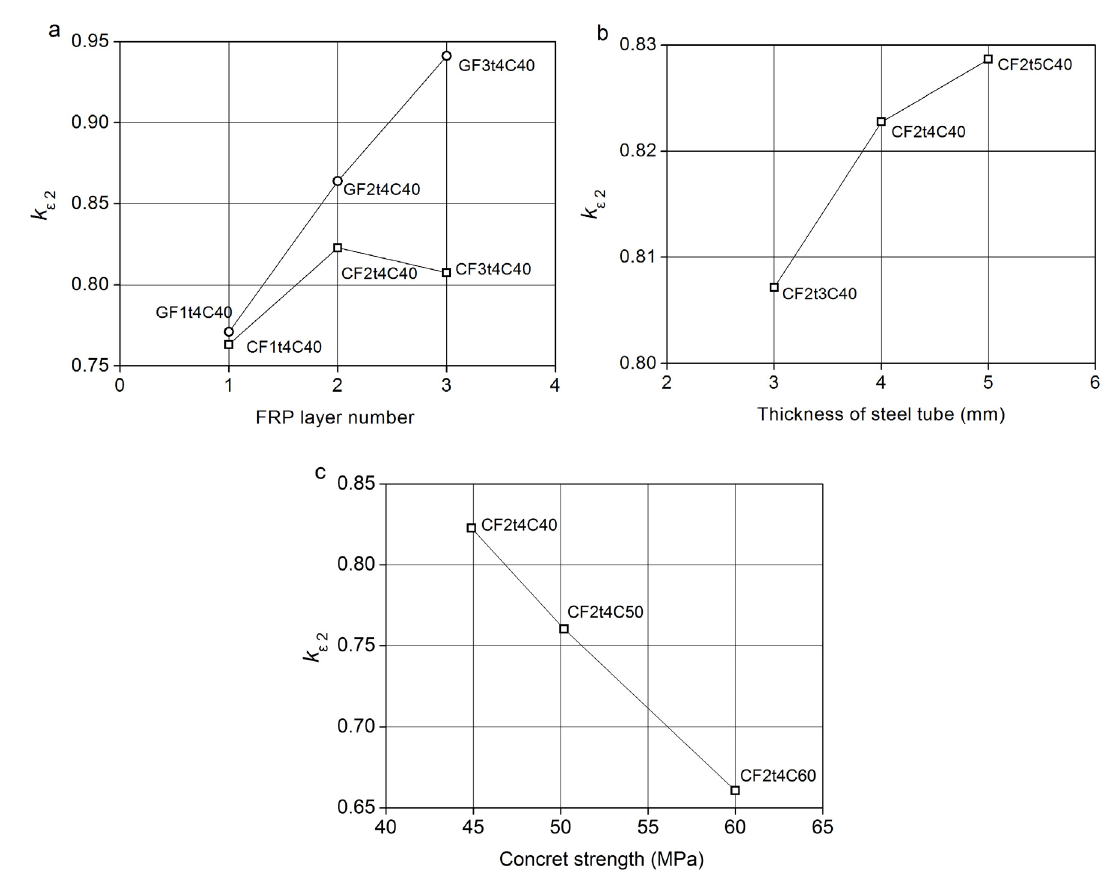
Figure 10. The values of k : ( a ) the FRP layer number; ( b ) the thickness of the steel tube; ε 2 ( c ) concrete